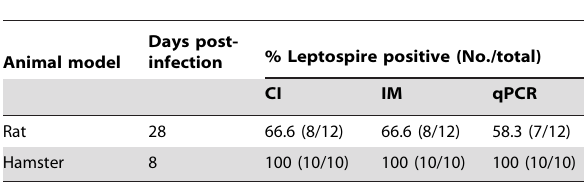
Table 1. Comparison of culture isolation (CI), the imprint method (IM) and real-time PCR (qPCR) for the detection of leptospires in animal models simulating chronic (rat) and acute (hamster)